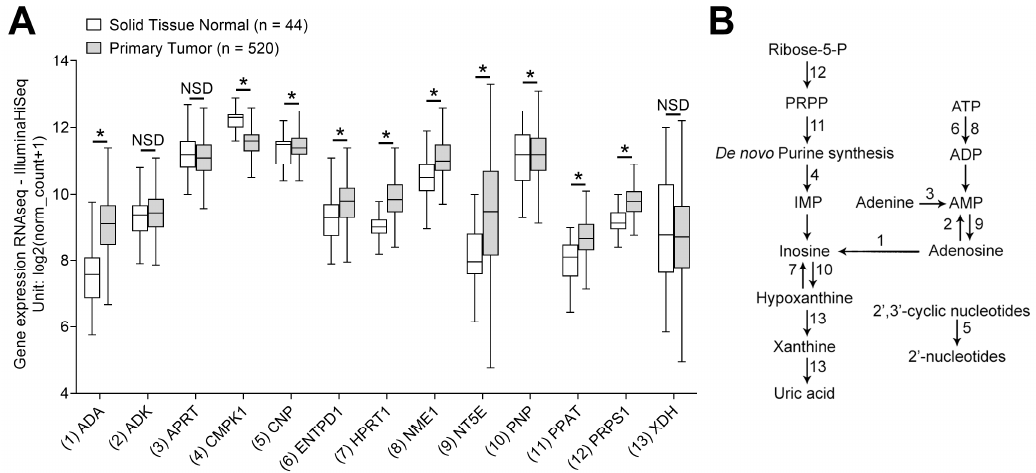
Figure 1. Analysis of gene expression levels of individual purine synthesis pathway mRNAs in the Cancer Genome Atlas (TCGA) database for head and neck squamous cell carcinoma (HNSCC) using the University of California, Santa Cruz Xena Browser. ( A ) Gene expression levels in 520 cases of primary HNSCC were compared to 44 solid normal tissues. Box and whiskers plot showing median, range of 25–75% and the minimum–maximum values. * p < 0.05. ( B ) A schema showing associations between purine metabolites. Numbers correspond to x -axis labels in ( A ) and indicate functions of enzymes that were analyzed using the TCGA database.